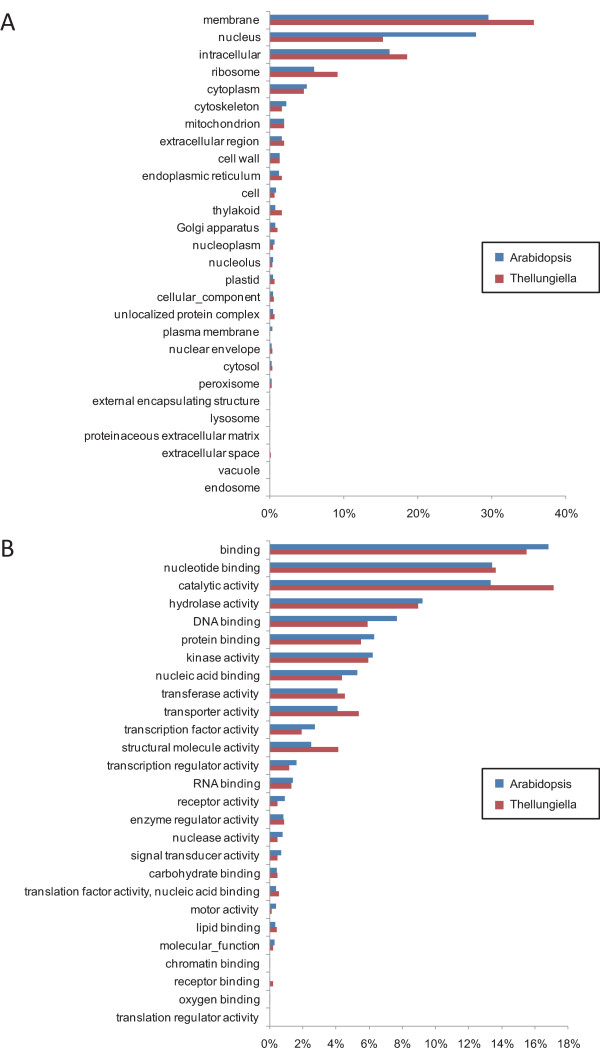
Comparison of the categories of Arabidopsis and nonredundant Thellungiella genes. The 28227 Arabidopsis genes and the 8298 nonredundant Thellungiella genes that were assigned InterPro IDs were classified according to the GO terms using Plant GO Slim  into categories based on (A) cellular components and (B) molecular function.